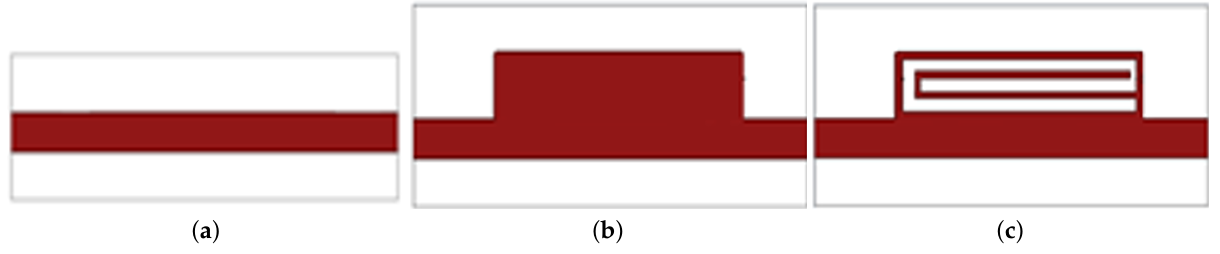
Figure 2. Microstrip line modified to filter with CSR ( a ) microstrip line ( b ) high impedance line loaded microstrip line ( c ) Complementary Spiral Resonator (CSR) loaded microstrip